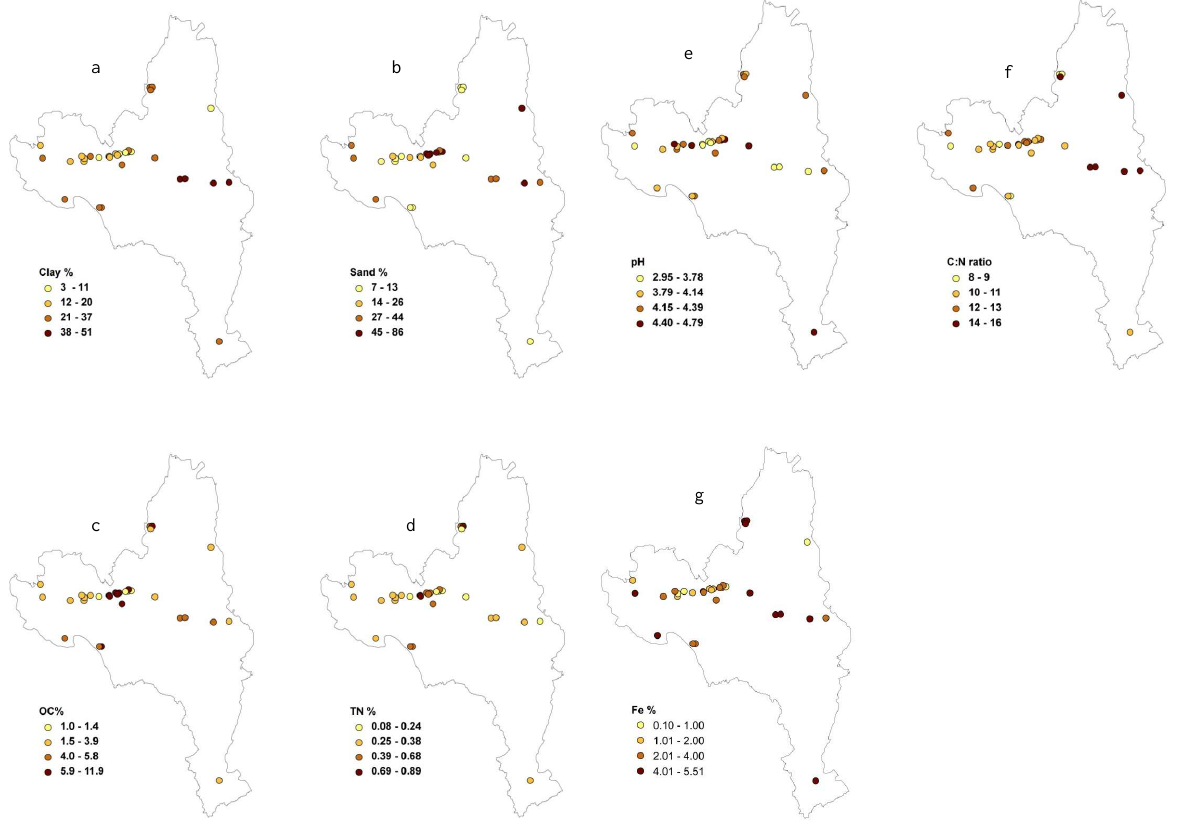
Fig. 2. Spatial pattern of the soil characteristics of the samples sites in the Nyungwe forest: clay (a) , sand (b) , organic carbon (OC) (c) , total nitrogen (TN) (d) , pH (e) , C:N ratio (f) , free iron (Fe) (g)